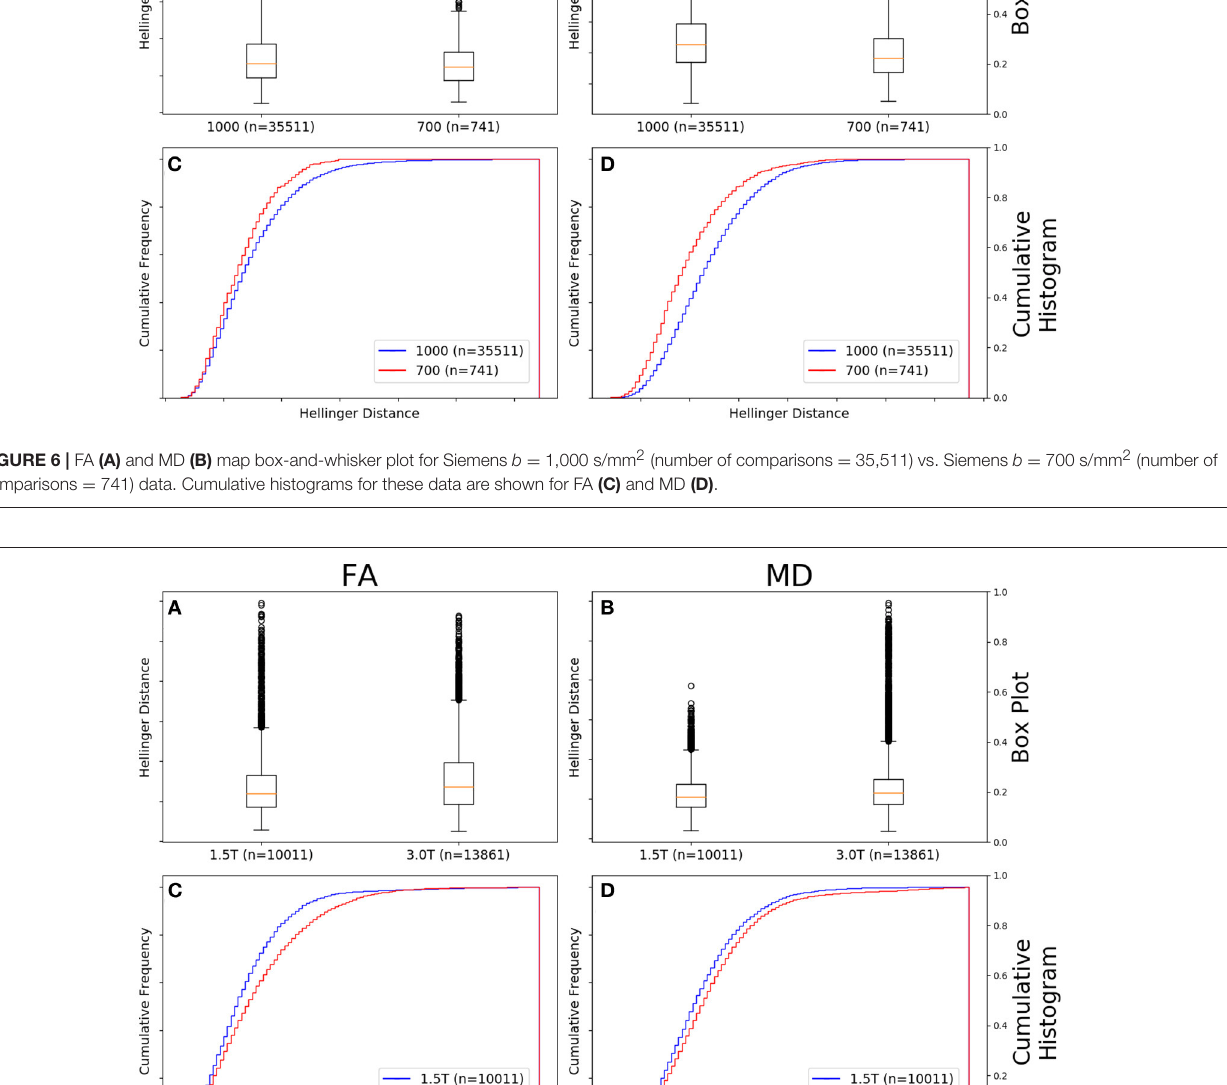
The Hellinger distance between the median and upper limit, excluding outliers, was 0.2610 for the 3.0T group and was 0.2379 for the 1.5T group. Figure 7D shows the cumulative frequency plots for each MD map Hellinger distance